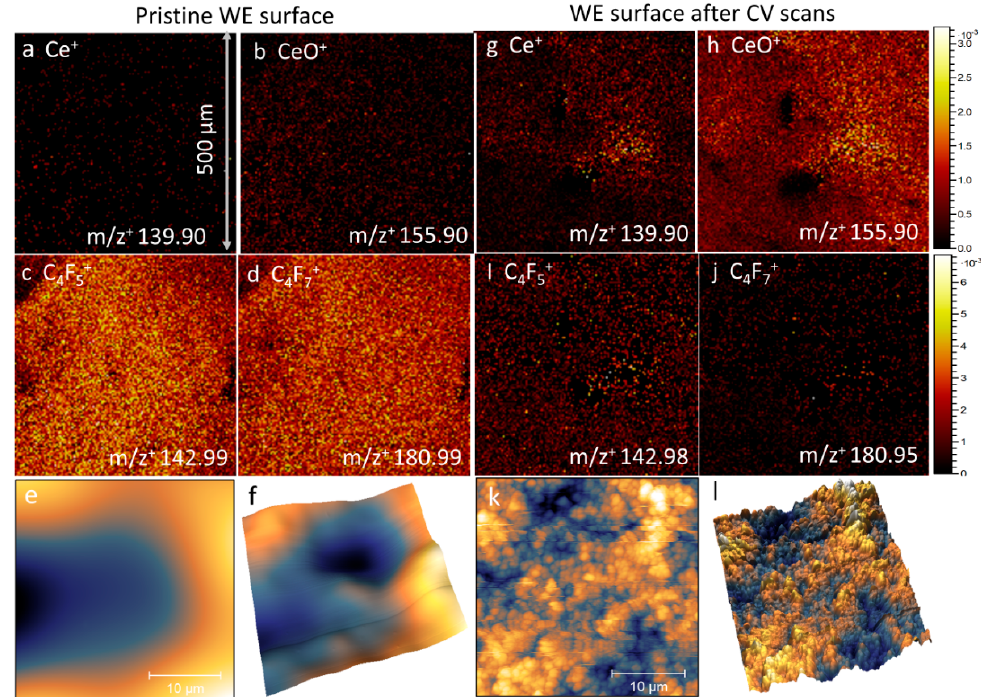
Figure 3. Normalized ToF-SIMS 2D positive ion images of representative CeO 2 particles and Nafion fragments on a pristine CeO 2 WE surface: ( a ) Ce + , ( b ) CeO + , ( c ) C 4 F 5+ , and ( d ) C 4 F 7+ . Corresponding AFM images of the as-fabricated electrode ( e ) 2D surface and ( f ) 3D amplitude images. Similarly, representative ToF-SIMS 2D positive ion images of the CeO 2 WE surface after CV scans depicted in ( g – j ) and AFM 2D/3D images ( k , l ), respectively.